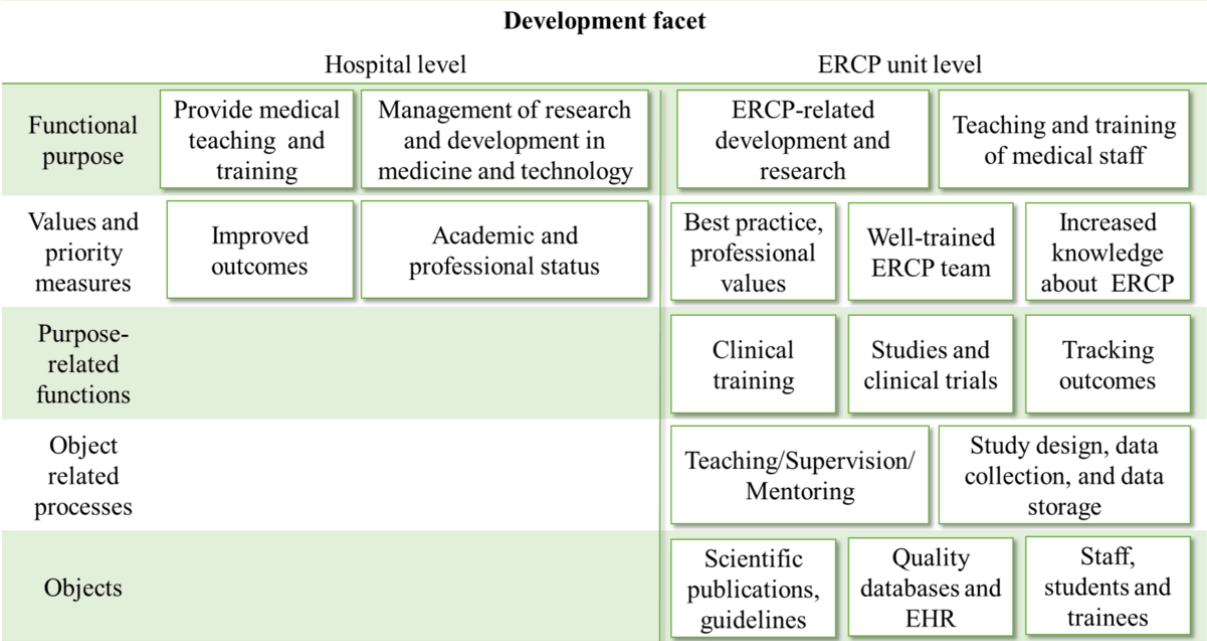
Figure 6. Abstraction hierarchy, development